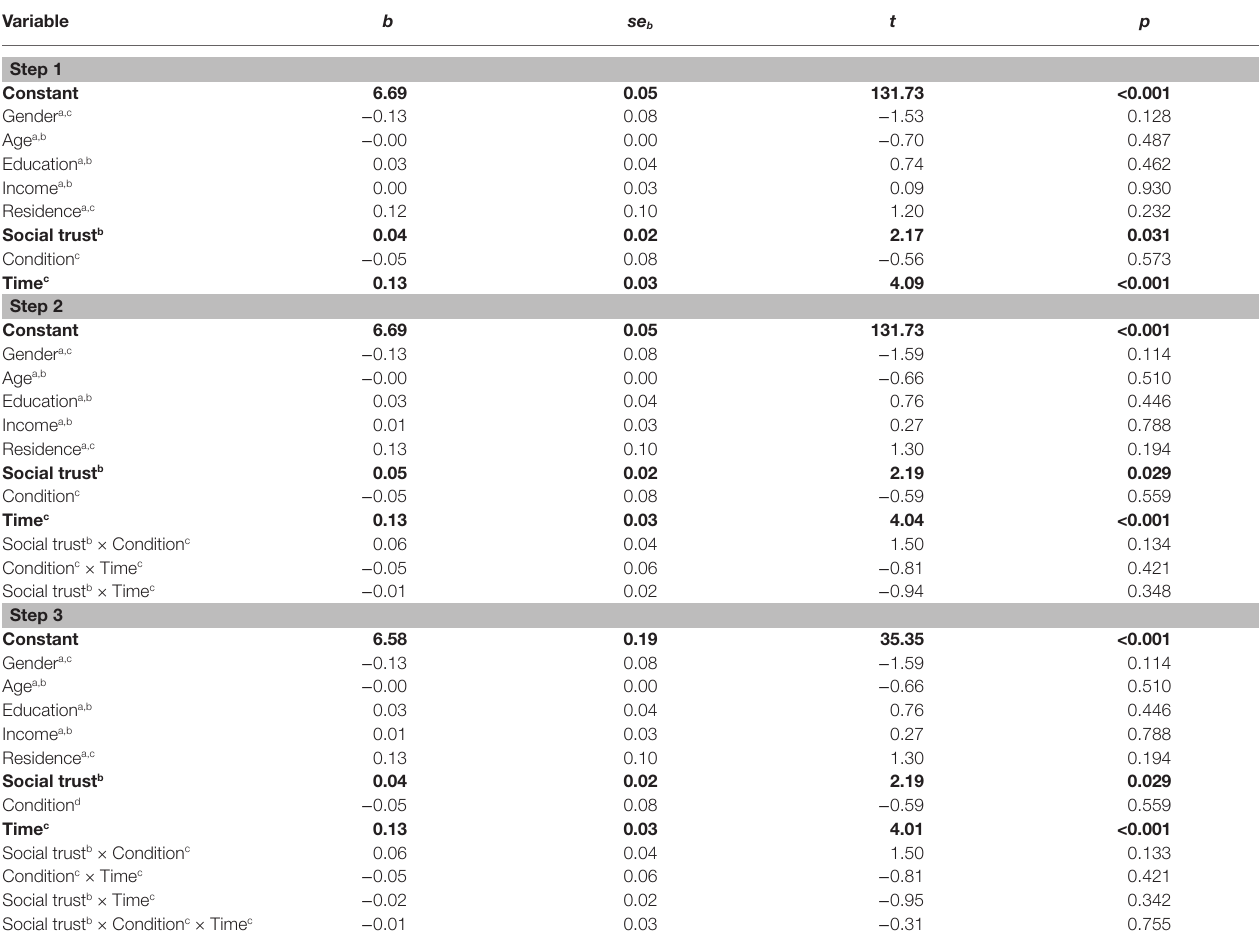
TABLE 3 | Mixed linear model results predicting social distancing for Study 2.